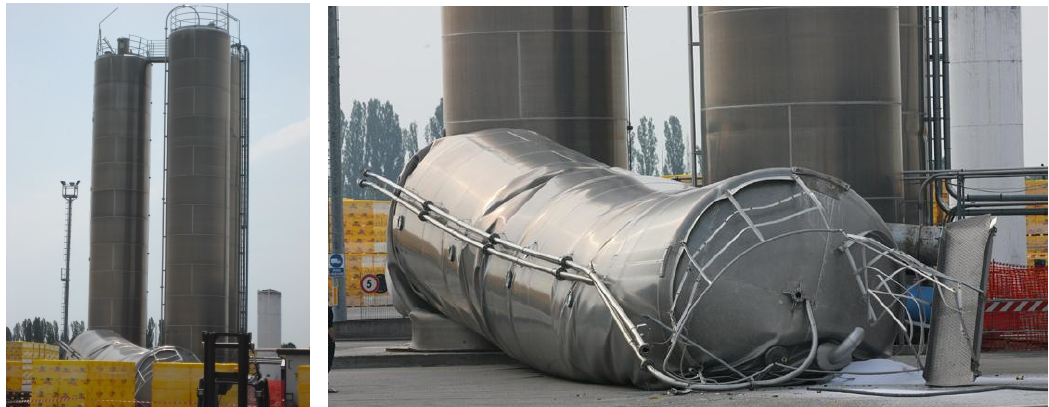
Figure 1. Total collapse of a slender silo during the earthquake series in Emilia Romagna/Northern Italy in 2012.